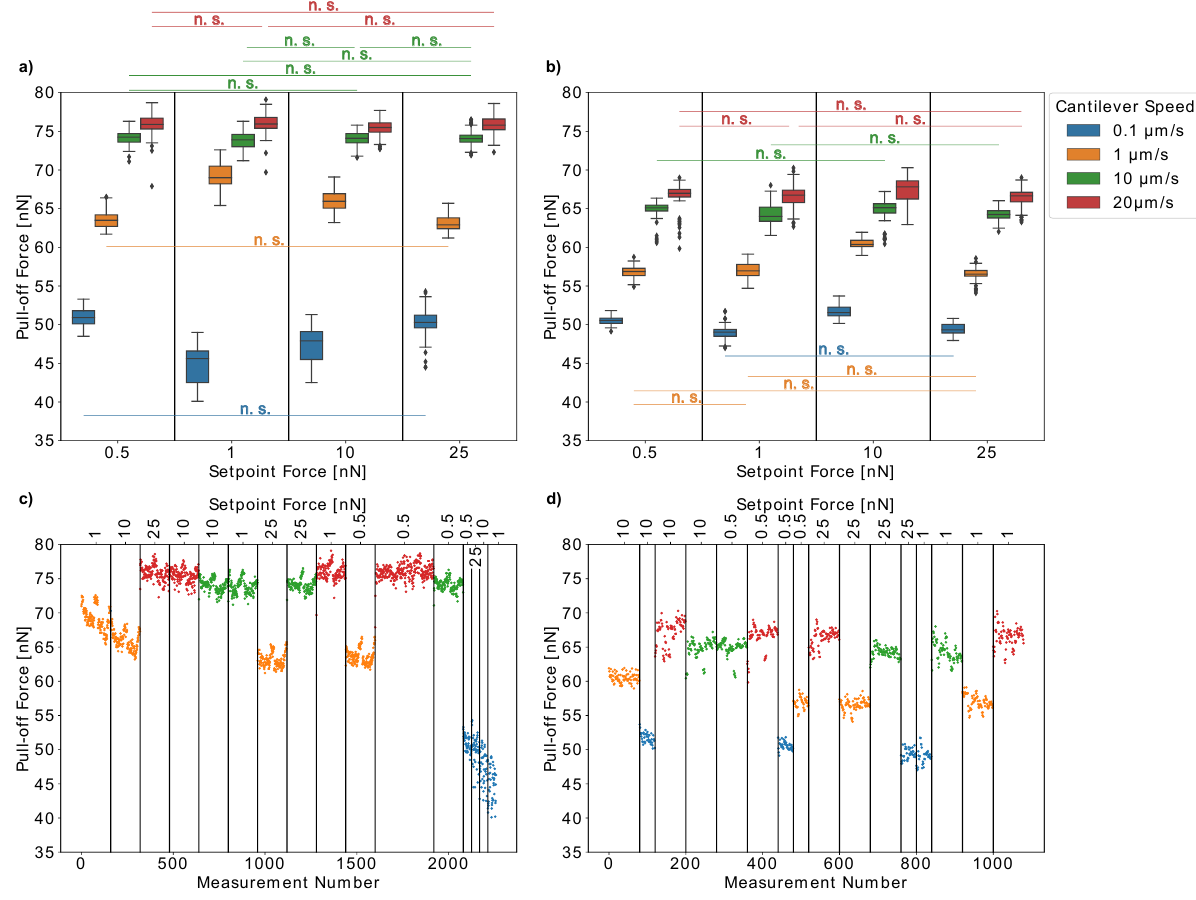
Figure 4. The influence of the setpoint force (contact force) and cantilever speed on the measured pull-off forces were analyzed for two fresh Hypochaeris radicata pollen. ( a , b ) The results presented as box plots. ( c , d ) The pull-off forces versus measurement number as an experimental control for the repeatability of measurements. For clarity, we only marked the boxes that are not significantly different from each other. Both individual pollen grains show an increase in pull-off forces with an increasing cantilever speed. The dependency on the setpoint force is not very pronounced. ( c ) The pull-off forces of the pollen presented in ( a ) decrease with a measurement number for low cantilever speeds, which could indicate that pollen aging influences our results. ( d ) The results obtained from the pollen presented in ( b ) were repeatable throughout the entire experiment. n.s.: no significance. On the other hand, the pull-off forces of the first pollen continuously decreased over time when measured at low cantilever speeds of 0.1 µm/s or 1 µm/s (Figure 4c). At higher speeds, the measurements are repeatable. This did not only result in broader distributions of pull-off force values, but it is also a possible explanation for the fact that the influence of the setpoint forces on the pull-off forces is much more pronounced for low pull-off rates (Figure 4b). At higher cantilever speeds of 10 µm/s and 25 µm/s, the pull-off forces are not strongly influenced by setpoint forces between 0.5 nN and 25